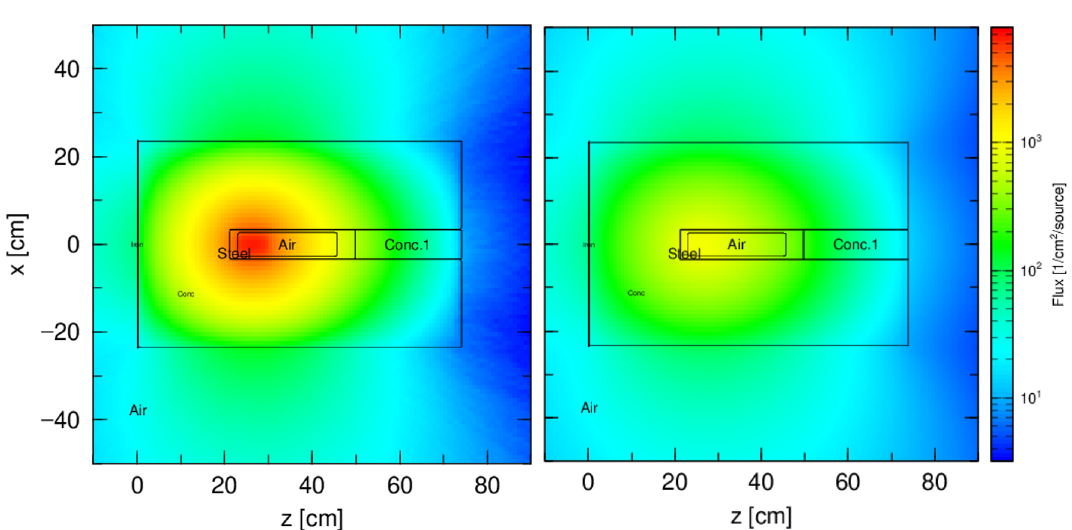
Figure 4. Neutron flux (left) and generated photon flux (right) obtained in the computed geometry from the DSRSs waste made of the compilation of 241 Am/Be sources in a P-60 capsule and stored in a barite concrete- filled drum. Monte Carlo view for a run of 5 000 000 initial